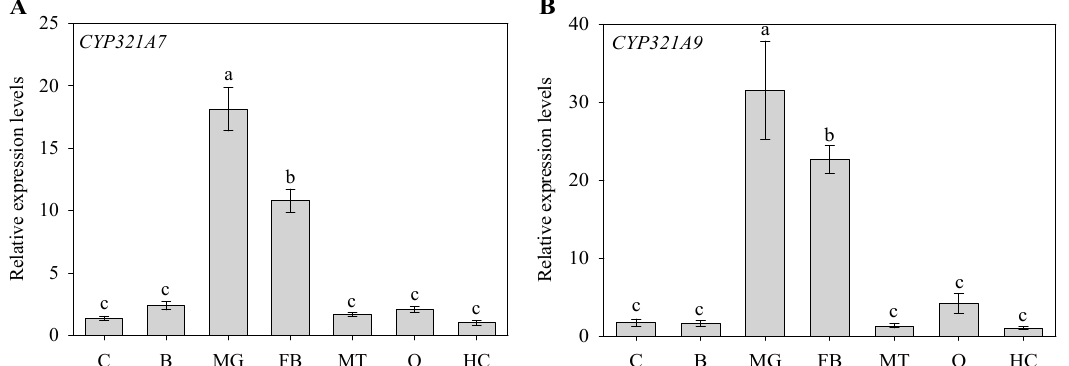
Figure 3. Expression of CYP321A7 ( A ) and CYP321A9 ( B ) in different tissues of 2-day-old fourth instar larvae of Spodoptera litura . Analyzed tissues: cuticle (C), brain (B), midgut (MG), fat body (FB), Malpighian tubule (MT), ovary (O) and hemocytes (HC). Reverse transcription–qPCR (RT–qPCR) analysis was used to determine the expression of CYP321A7 and CYP321A9 as described in the Experimental Section. The β -actin gene served as an internal reference to determine relative expression levels. Data shown are means ± standard error (SE) (three biological replicates). Different letters above bars indicate significant differences ( p < 0.05) according to the Duncan’s multiple